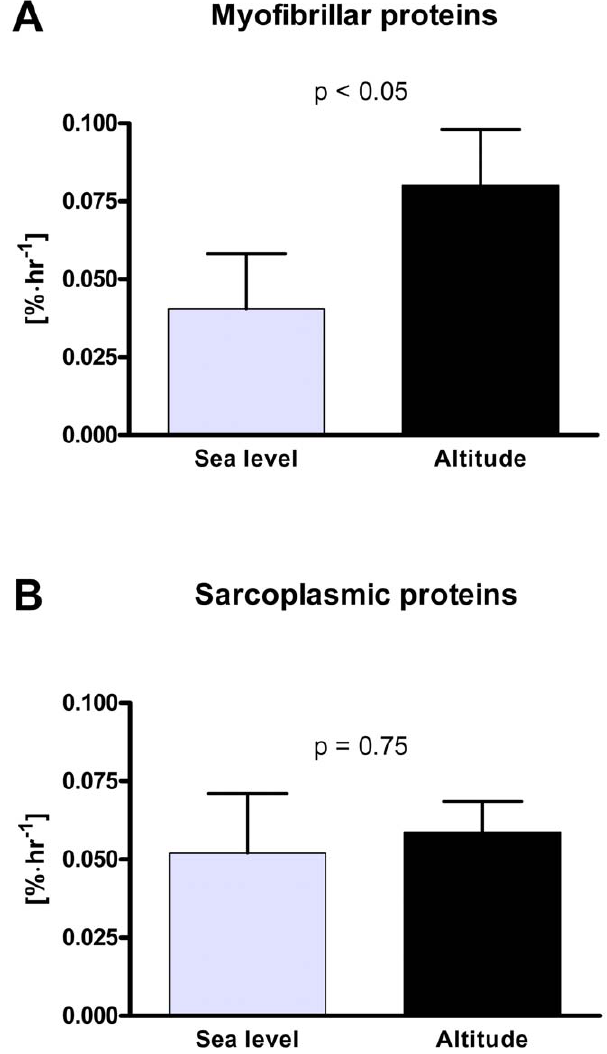
Figure 1. Muscle protein fractional synthesis rate. Resting and fasting fractional synthesis rate [% ? hr 2 1 ] of A) myofibrillar proteins and B) sarcoplasmic proteins at sea level and after 7–9 days of acclimatization to 4559 m altitude. N=8 and values are mean 6 SEM.